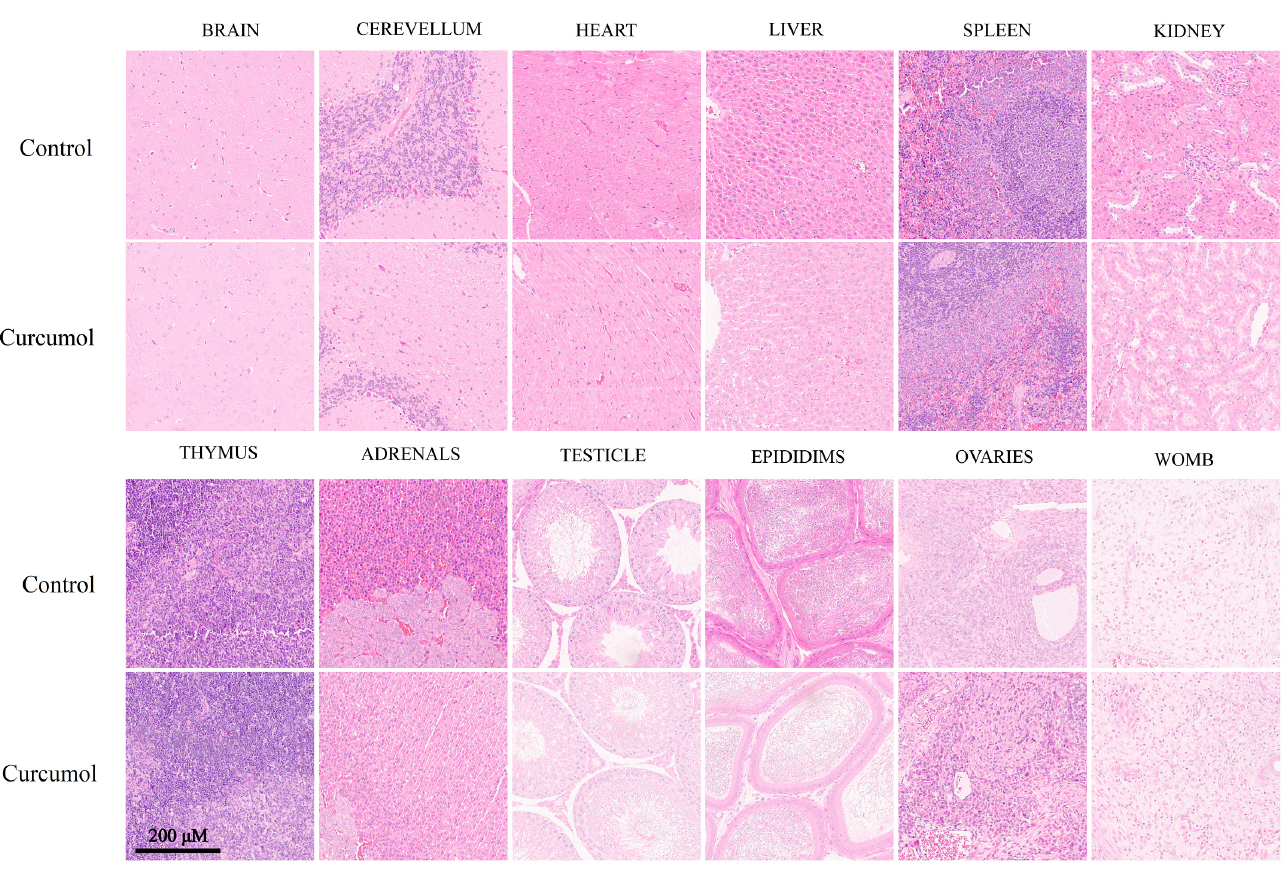
According to the guideline, tissues from the male and female rats exposed to the 1000 mg/kg dose were submitted for the histopathological examination, and no abnor- mality or unusual damage was observed in these organs when compared with the control (Figure 2).